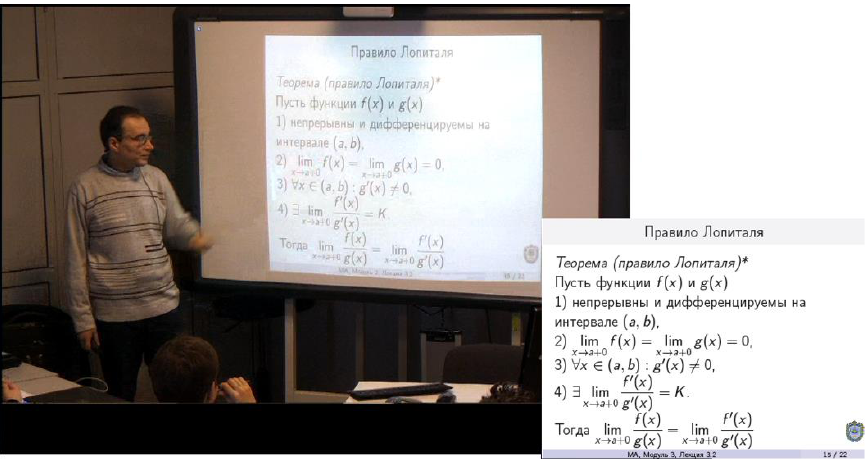
Fig. 4. A screenshot of video lection on L’Hospital rule (“Mathematical analysis” online course). Table 4. Contains of Figure